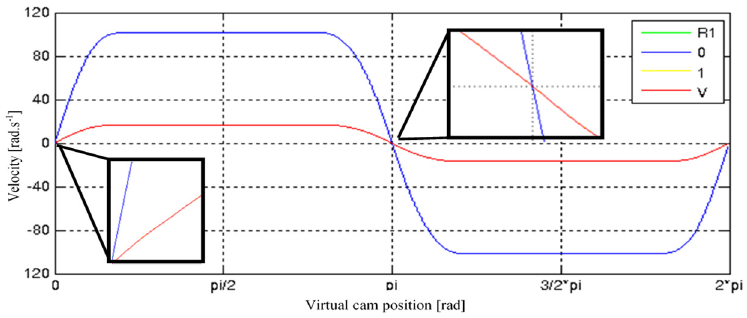
Figure 11. Courses of angular velocities of individual drive system elements.